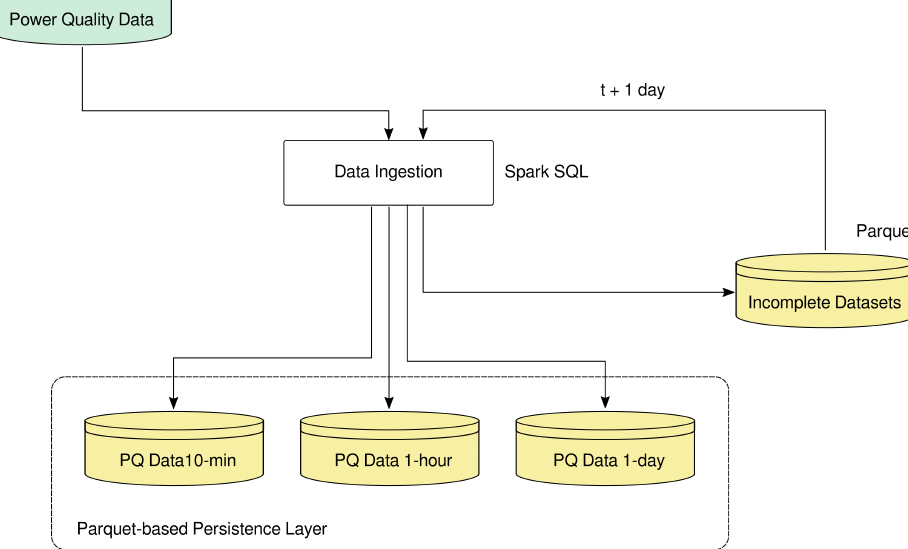
Figure 3. Data-ingestion component of MIRD. The pipeline ingests all time series at day t . It records unavailable time series on the Incomplete Datasets archive. At day t + 1, they are either recovered or kept in the archive for further